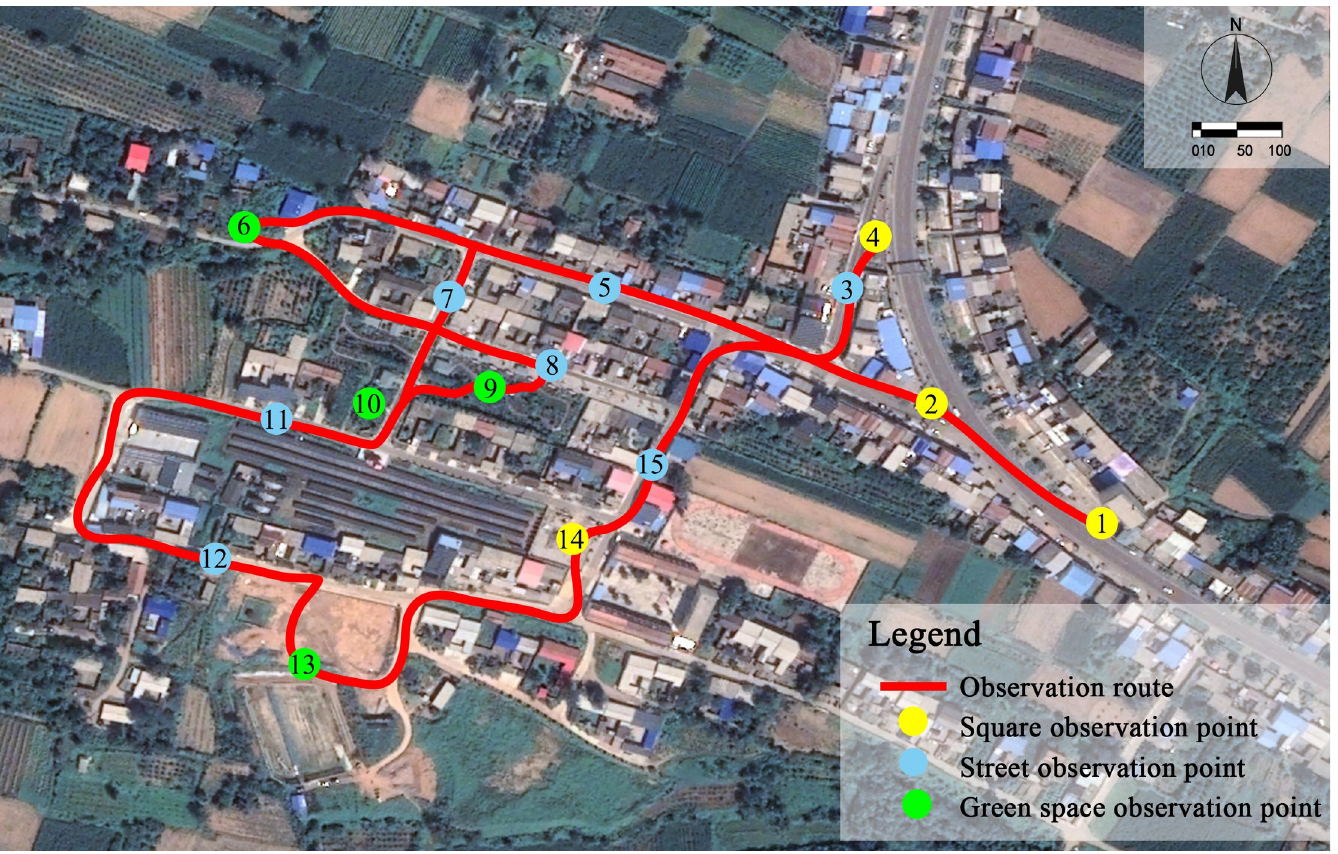
Fig 2. Distribution of measurement points. (The satellite images in Fig 2 with permission from Beijing Qianfan Shijing Co., Ltd, original copyright [2020] [96]).